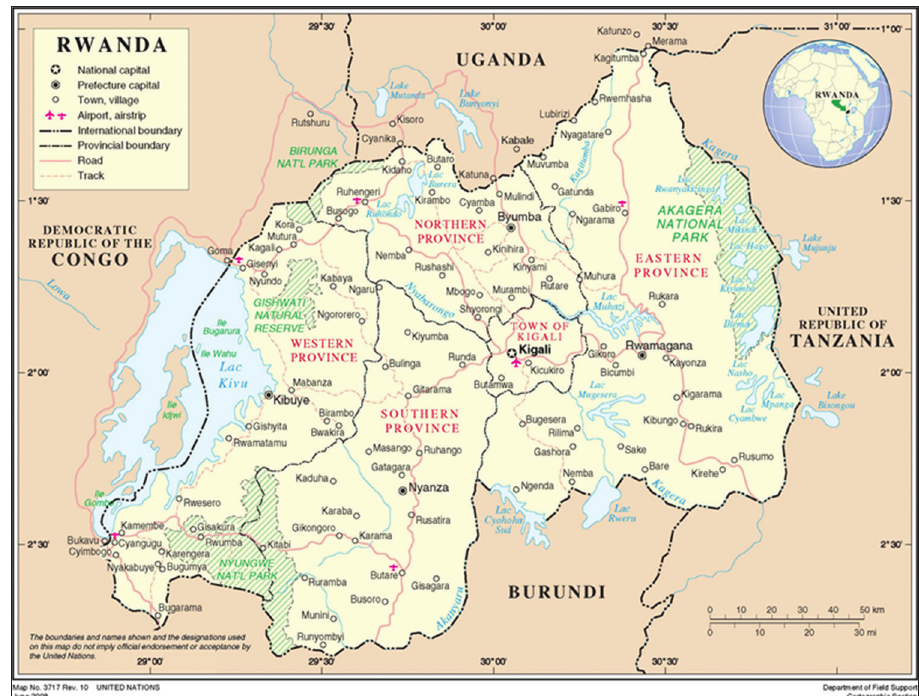
Figure 1 : Political and Administrative Maps of Rwanda; Source: UN Country Data and Rwanda Development Board: http://www.theiguides.org/public-docs/guides/rwanda